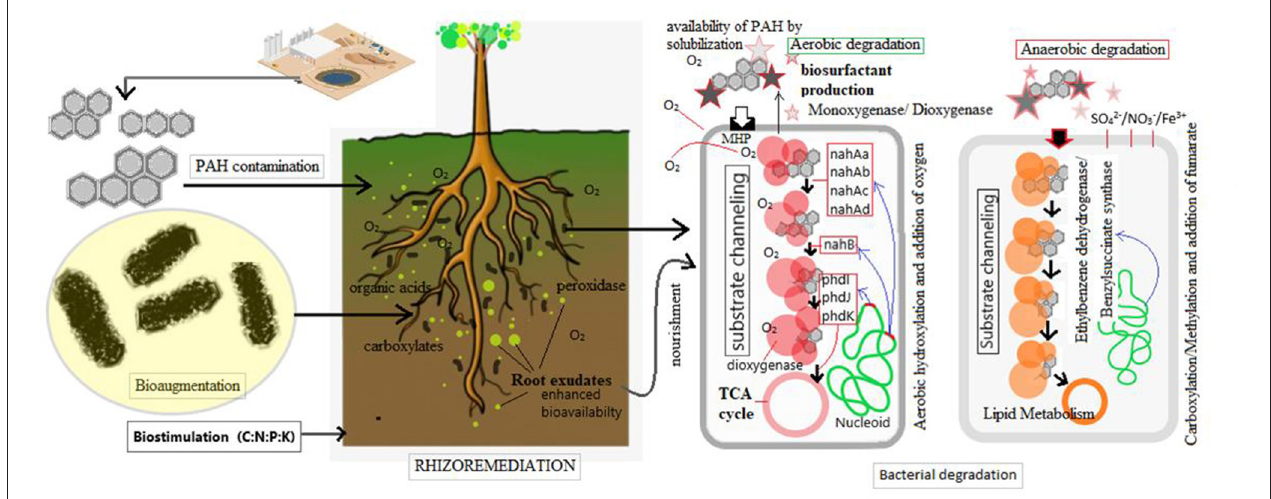
FIGURE 1 | Different approaches for the bioremediation of Polyaromatic Hydrocarbon contamianted